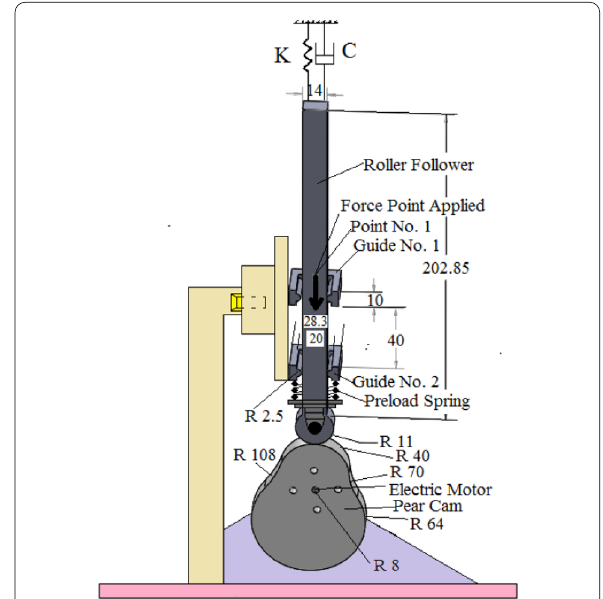
Figure 2 Contact model of cam-follower